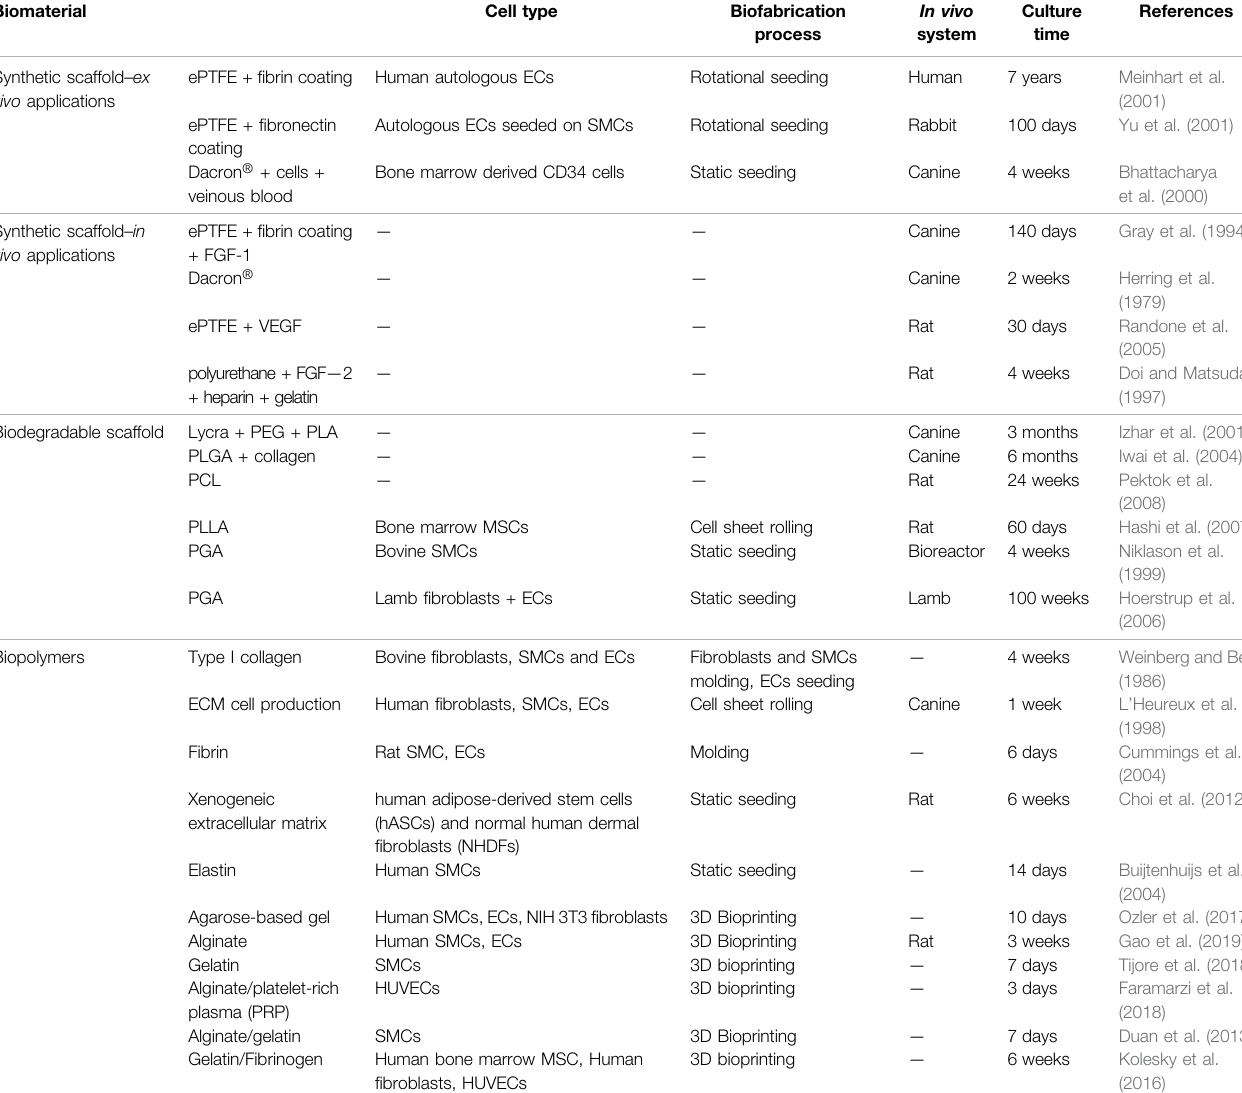
TABLE 1 | The different categories of biomaterials used in vascular tissue engineering.